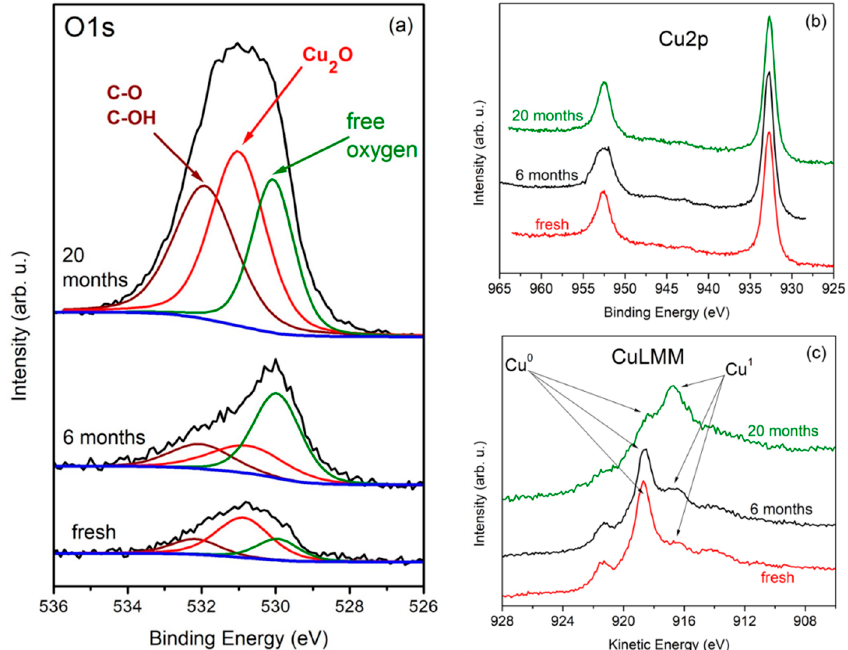
Figure 3. XPS spectra depicting the surface state of the Cu foil in the investigated three samples: ( a ) O1s spectra with fitting components—free O (green), O in Cu 2 O (red) O in C-O bonds (brown); ( b ) Cu 2p spectra; ( c ) Cu LMM Auger spectra.